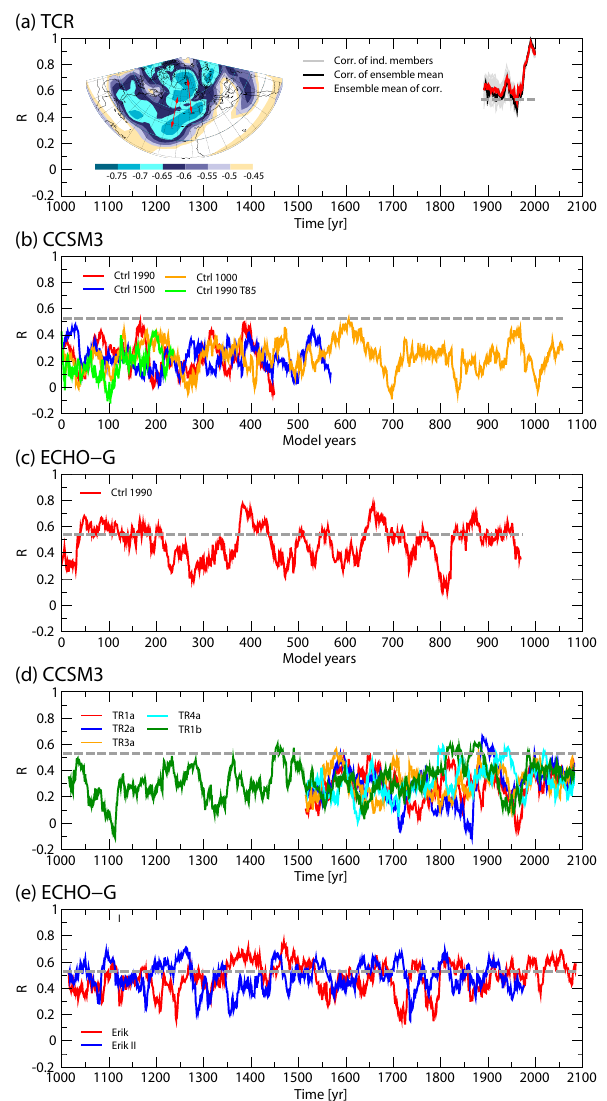
Fig. 3. Running spatial correlation time series using a 30-year win- dow and the reference teleconnectivity pattern (inset in a ) for the Atlantic: (a) TCR 1871 to 2010, (b) CCSM3 Ctrl simulations, (c) Ctrl1990 of ECHO-G, (d) transient simulations with CCSM3, and (e) transient simulations with ECHO-G. In (a) the black time se- ries shows the running spatial correlations using the ensemble mean TCR data; the grey time series are the running spatial correlations for each individual member of TCR and in red the mean of the grey time series is presented. The 1% significance level of the pattern correlation is illustrated by the grey dashed